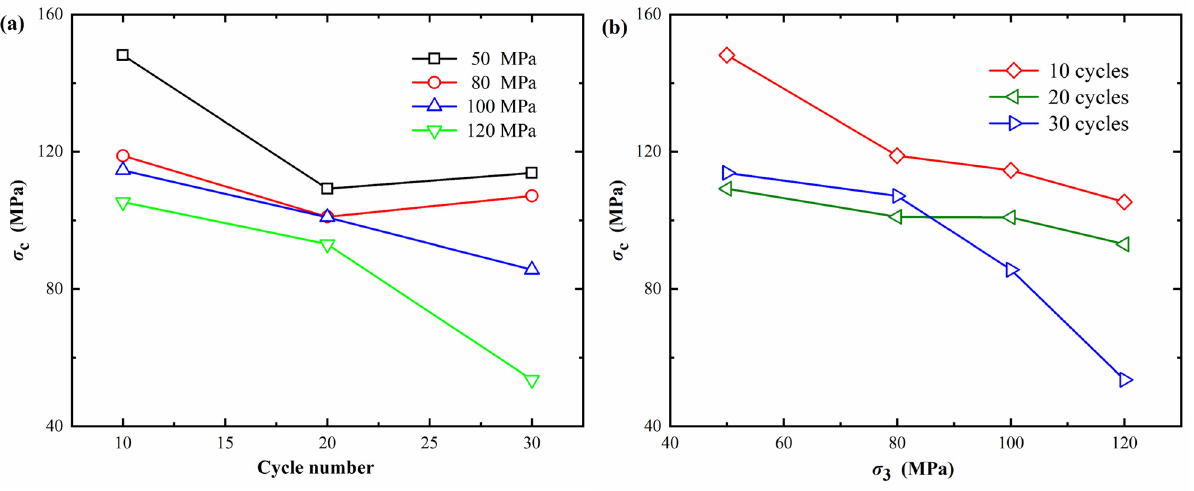
Figure 7. Strength characteristics of pre-damaged specimens. ( a ) Relationship between σ c and the cycle number; ( b ) relationship between σ c and σ 3